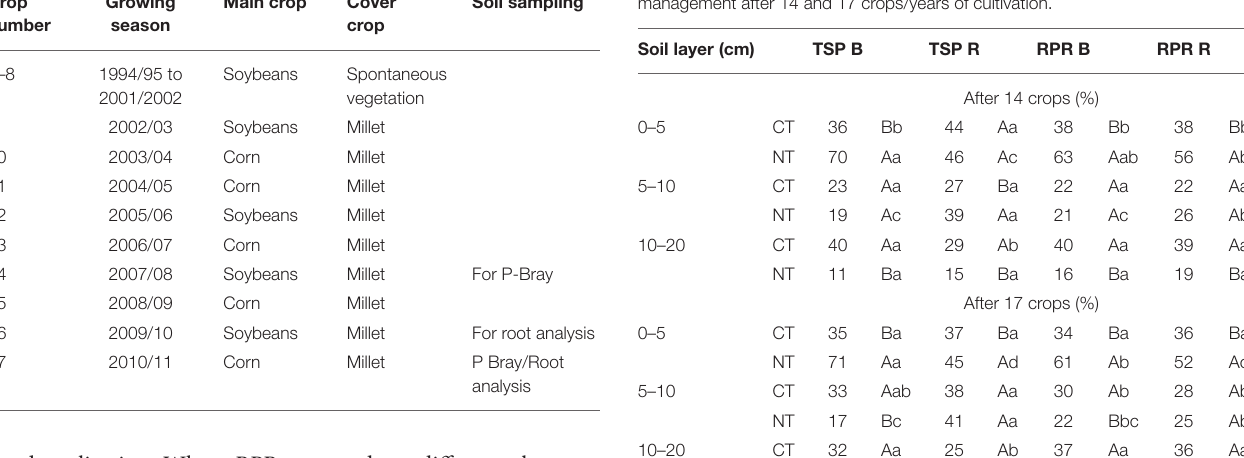
TABLE 3 | Relative distribution (%) of soil P availability (Bray-1) in three layers of a very clayey Oxisol under different soil tillage systems and phosphate fertilization management after 14 and 17 crops/years of